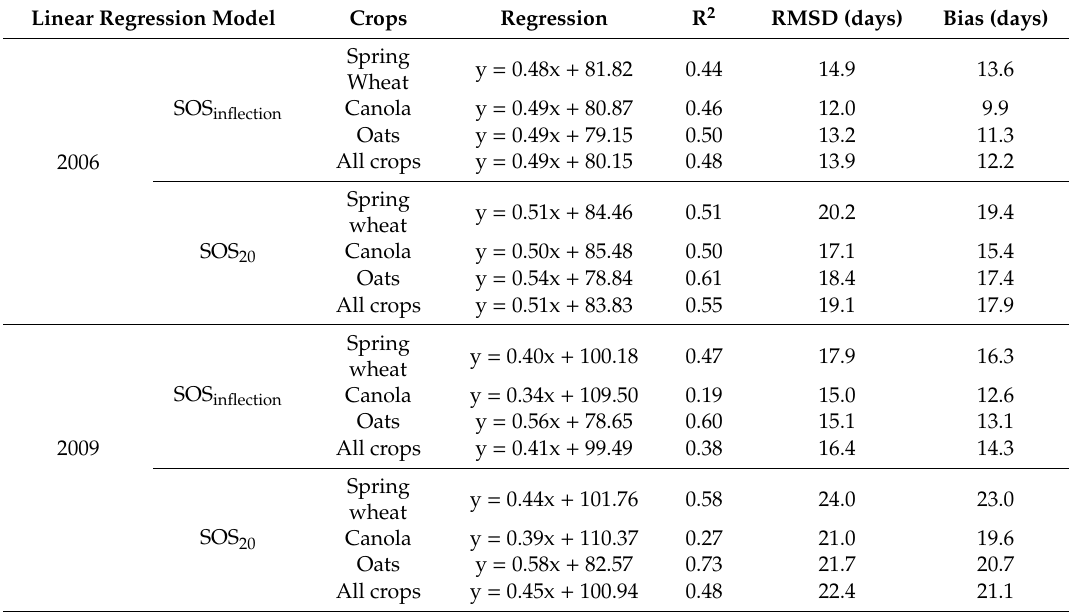
Figure 4. Scatter plot of observed seeding date and remotely sensed SOS for different years: 2006 ((a) and (c)) and 2009 ((b) and (d)); DOY is the day of year, and the dashed black line denotes the 1:1 lines.